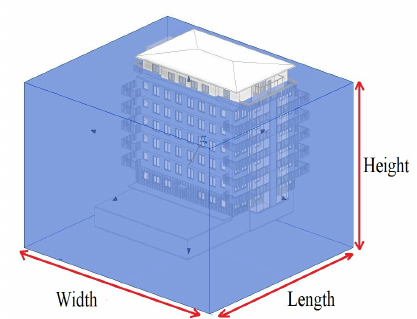
Figure 1 . Height limits modelled by using linear extrusion.